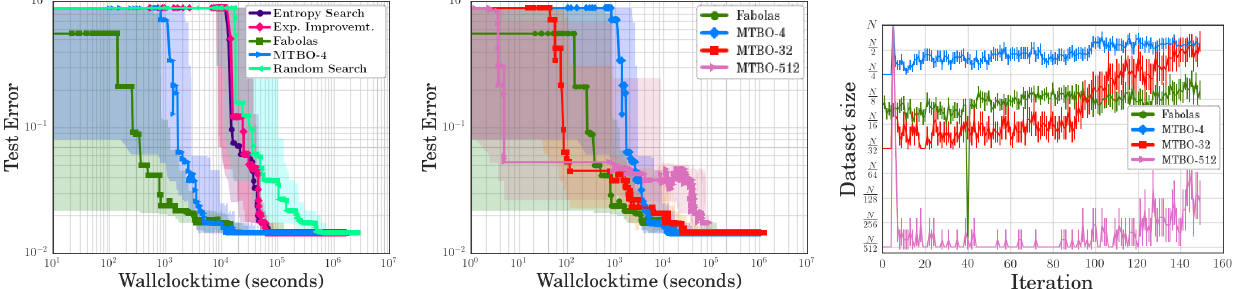
Figure 3. SVM optimization on the MNIST dataset. ( Left ) Comparison of the test performance over time of different optimizers. ( Middle ) Comparison of Fabolas with different MTBO subsample sizes. ( Right ) Comparison of the subsample sizes s that MTBO and Fabolas choose for their